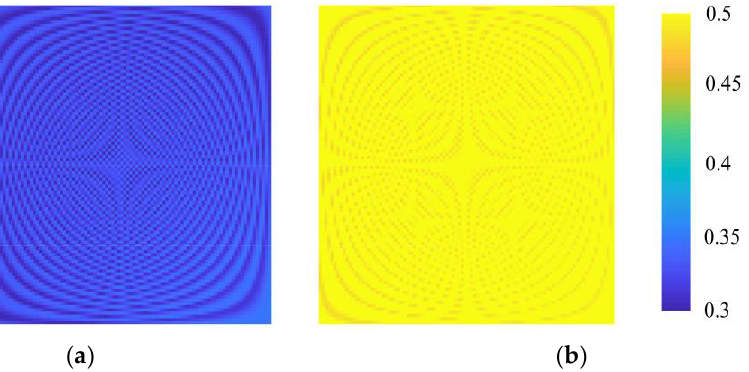
Figure 5. The scattering entropy for different soil moisture values. ( a ) 3% soil moisture; ( b ) 18% soil moisture.